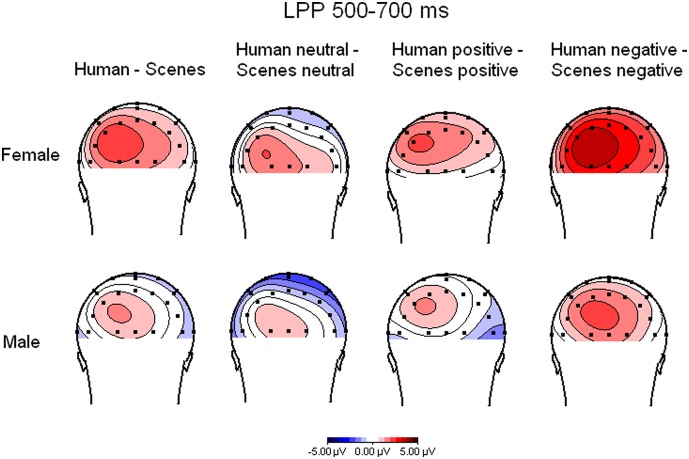
Topographical maps of the difference waves of ERPs in response to pictures with and without humans independent of valence (most left), neutral pictures with humans minus neutral pictures without humans, positive pictures with humans minus positive pictures without humans, and negative pictures with humans minus negative pictures without humans (most right).